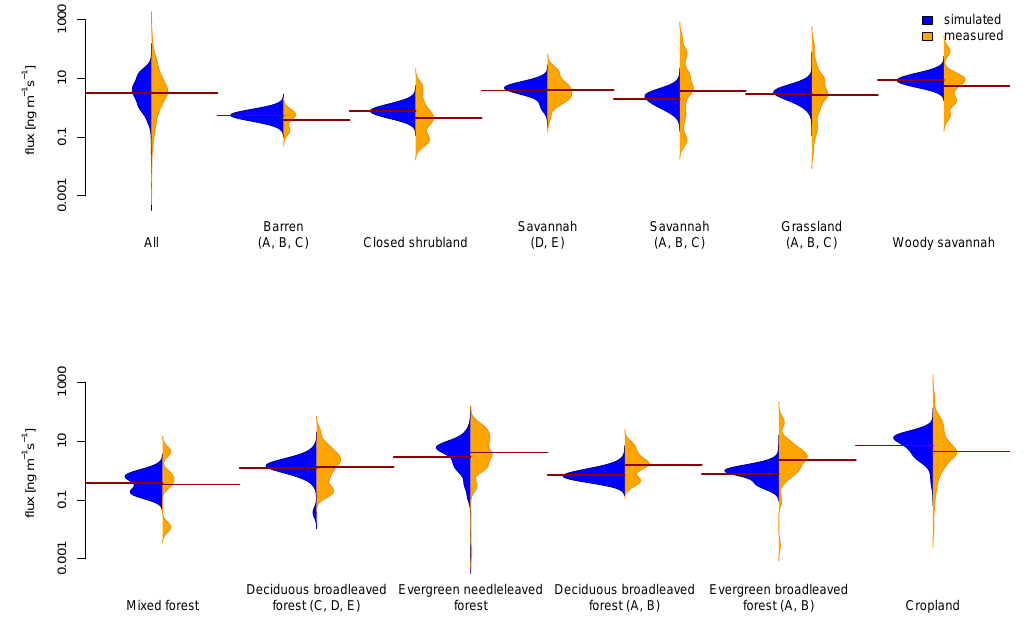
Fig. 14. Density function plot of SNO x measurements (orange, right of center line) versus model output (blue, left of center line) for the YL95/SL11 simulation using the program by Kampstra (2008).